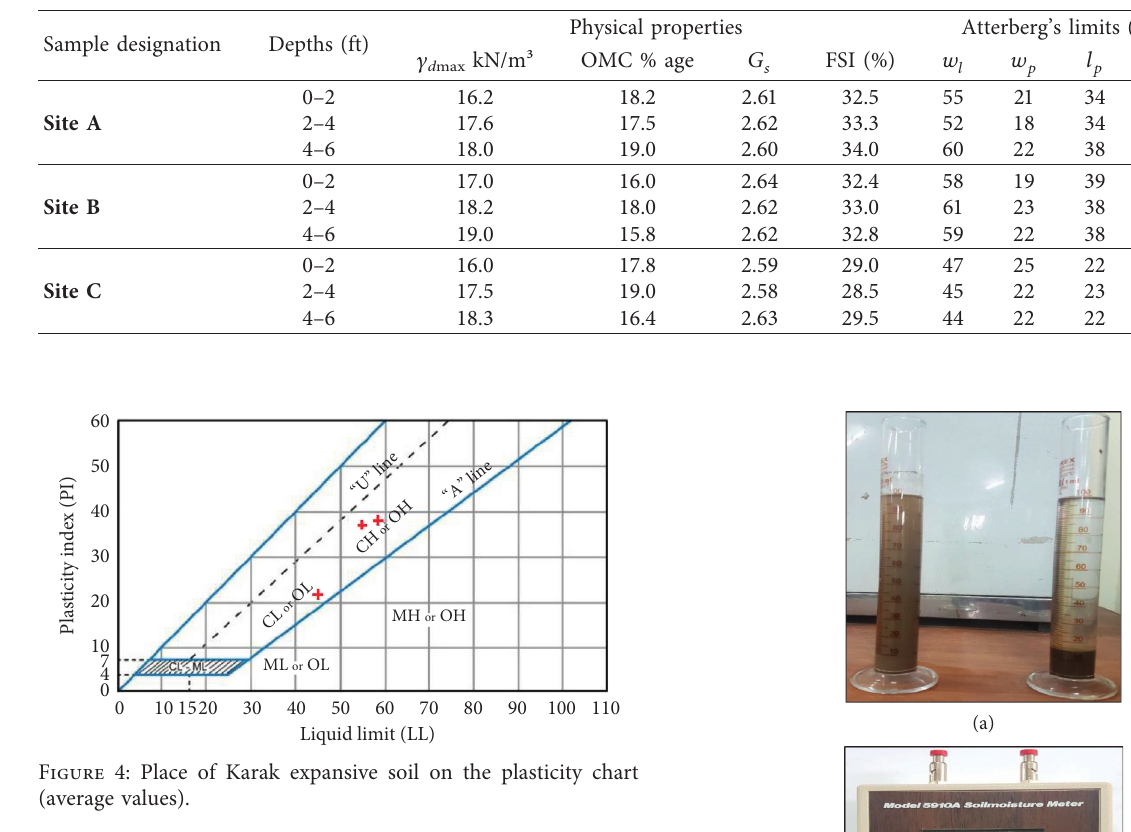
Table 1: Physical and swelling properties of the investigated soil.